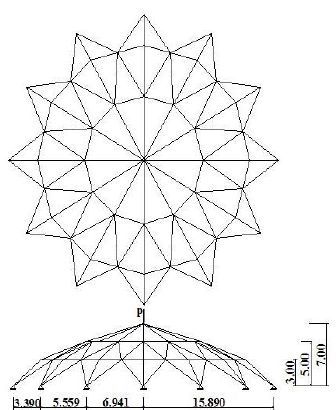
Figure 6. Space truss with 120–members, all dimensions are in mm [28].